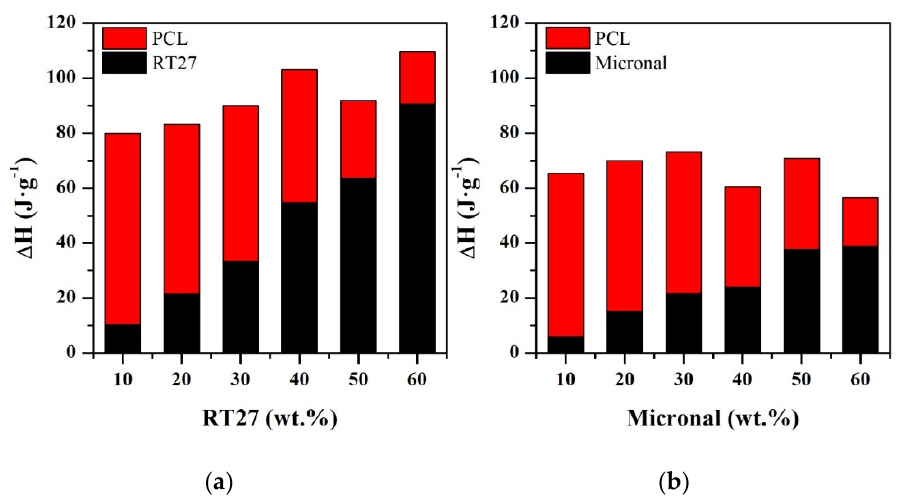
Figure 5. ( a , b ) Enthalpy of the different components of CSS-PCM manufactured.